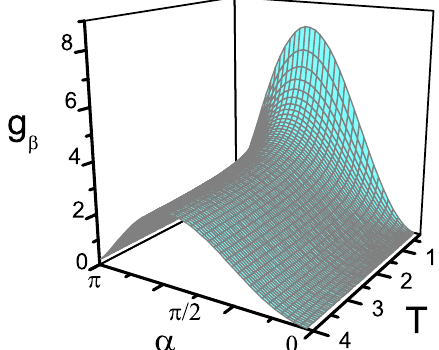
Fig. 4 The quantum parameter estimation with respect to β is evalu- ated by G β as a function of the amplitude α and radiation